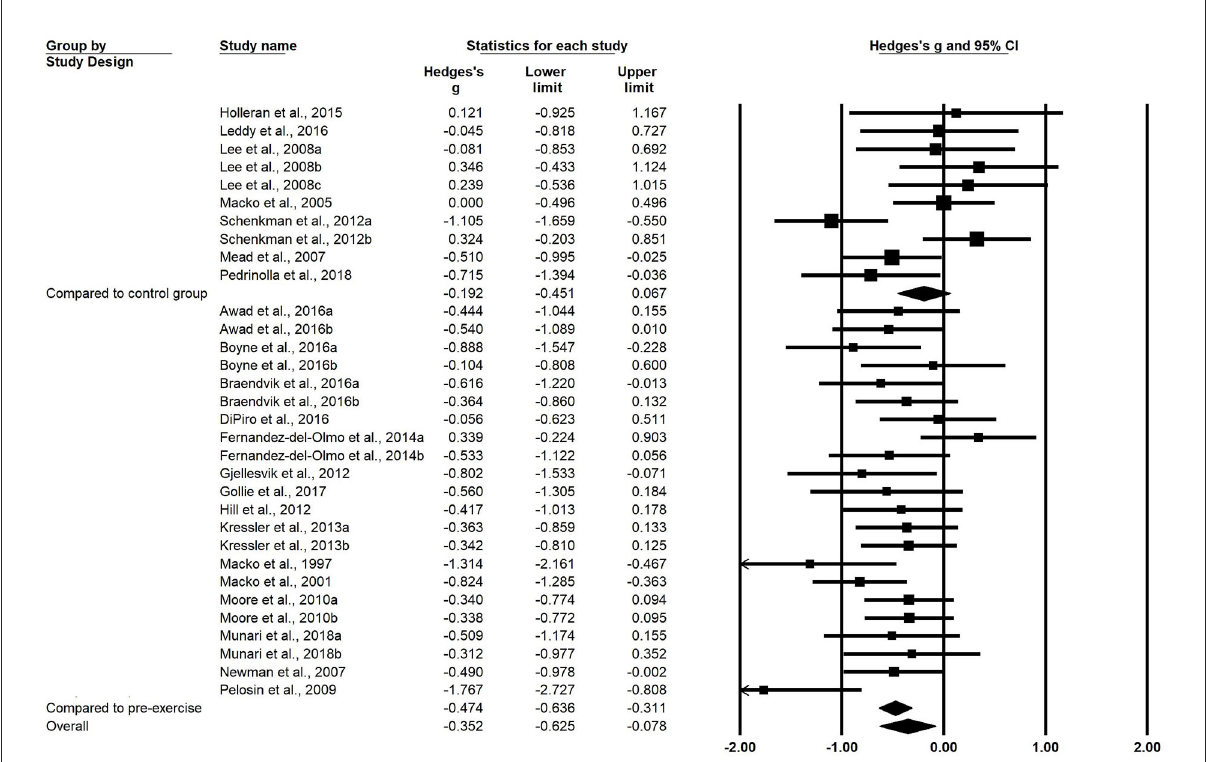
FIGURE2 Forest plots of effect sizes and 95% CIs for changes in walking economy after exercise intervention. The superscript numbers refer to different exercise programs assessed in the same study. CI, confidence